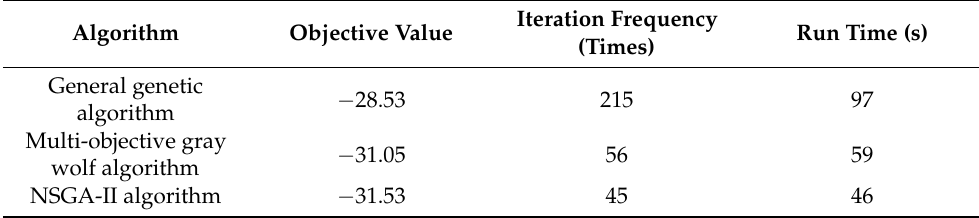
Table 12. Algorithm efficiency